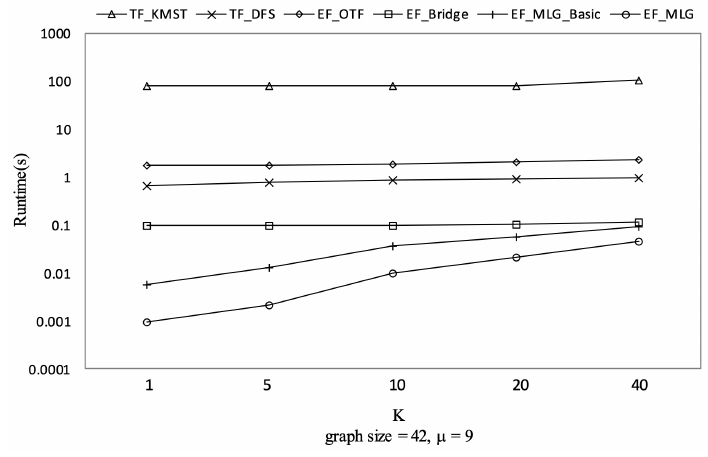
Figure 15. Runtime on GraphGen vs. k with graphsize = 42 and µ =